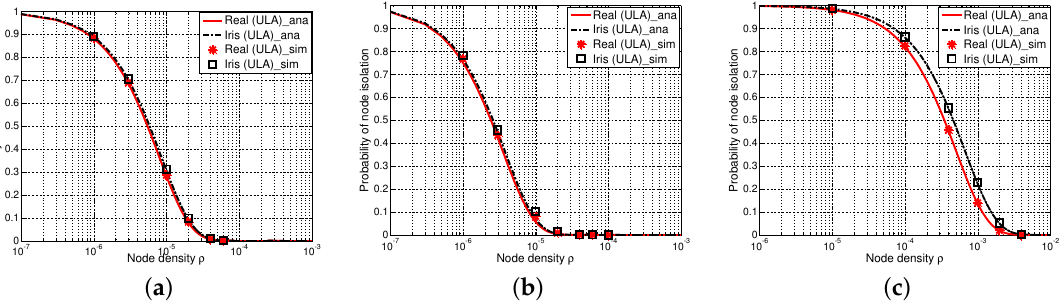
Figure 9. Probability of node isolation P ( iso ) with the ULA antenna and iris-ULA model, where curves are analytical results and markers are simulation results. ( a ) α = 2.5, σ = 4; ( b ) α = 2.5, σ = 8; ( c ) α = 4, σ =